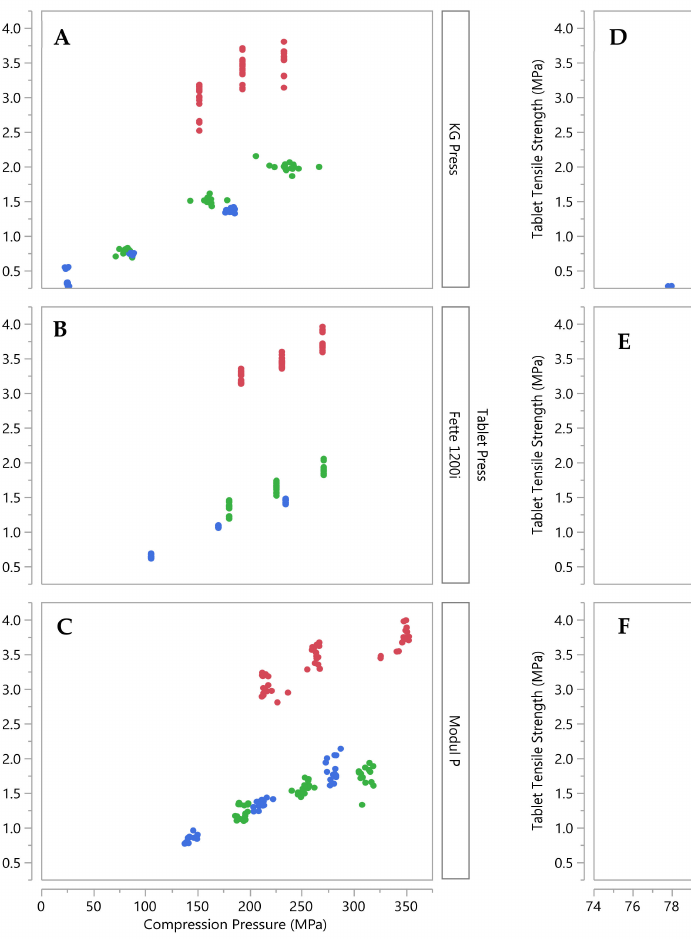
Figure 2. Compaction behaviour of three placebo formulations compressed on three tablet presses using processing parameters defined by the DoE. Red circles indicate formulation 1 (plastic), green circles indicate formulation 2 (elastic) and blue circles indicate formulation 3 (brittle). ( A – C ) Tabletability profiles, ( D – F ) compactibility profiles and ( G – I ) compressibility profiles of the three formulations on three tablet